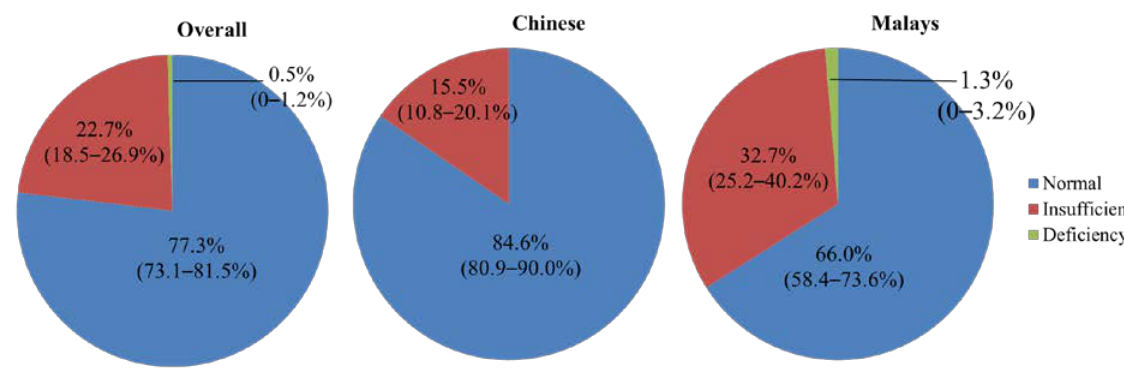
Figure 1. Vitamin D status of the subjects.